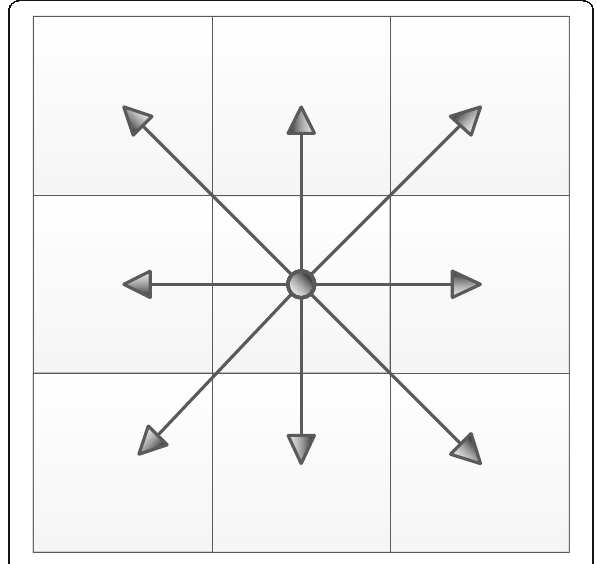
Fig. 2 Unmanned vehicle movement direction. Figure shows the default movement direction of the